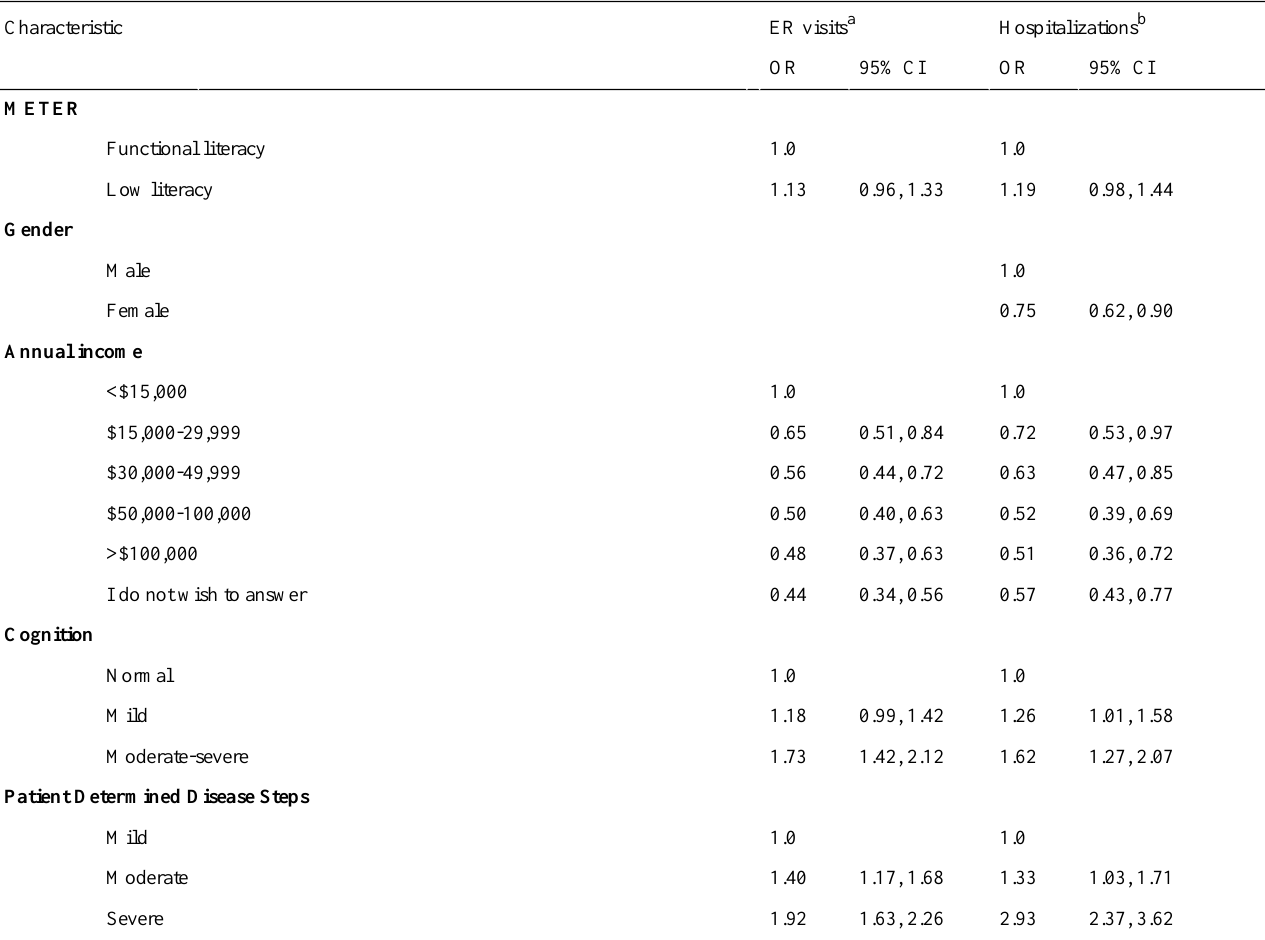
Table 5. Association of health literacy assessed by the Medical Term Recognition Test (METER) with emergency room (ER) visits and hospitalizations.